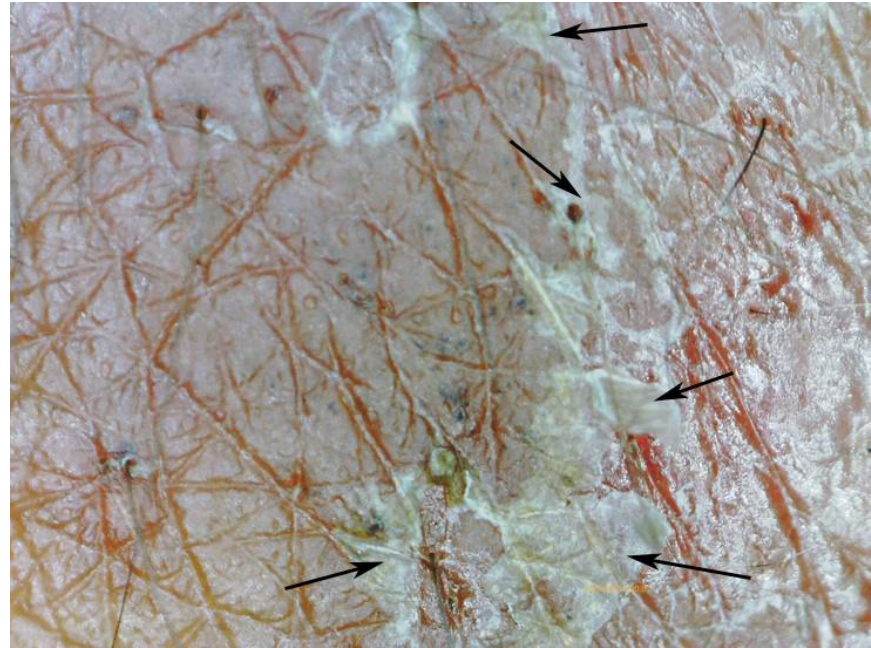
Figure 12. Microscopic excoriations of the stratum corneum not visible microscopically (arrows); magnification 100-fold.